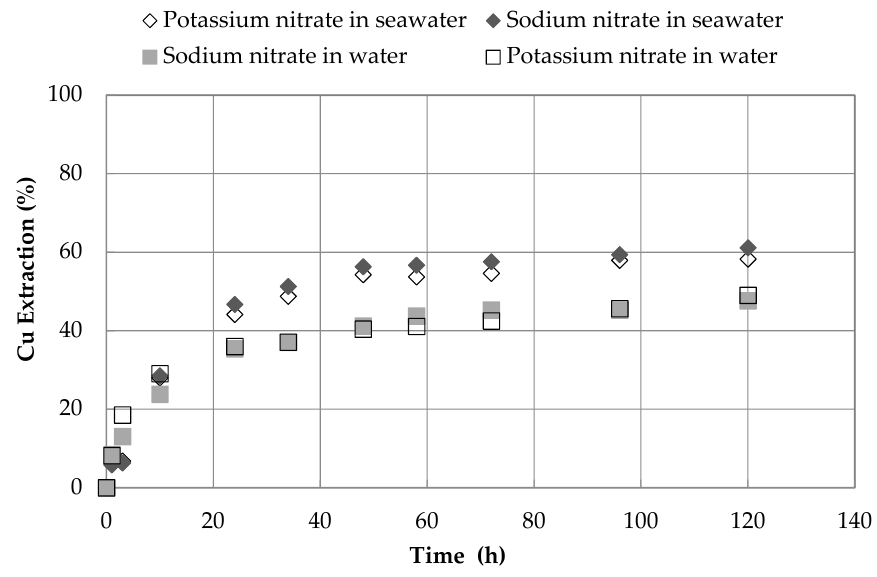
Figure 3. Effect of nitrate type on copper extraction. Experimental conditions: H 2 SO 4 (0.5 M), NaNO 3 (0.5 M), KNO 3 (0.5 M), 5 days of leaching and 45 °C.